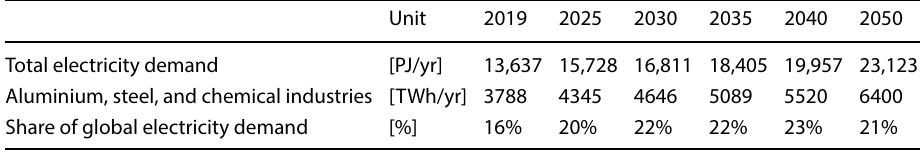
Table 16 Total global process demand, by temperature level, in the aluminium, steel, and chemical